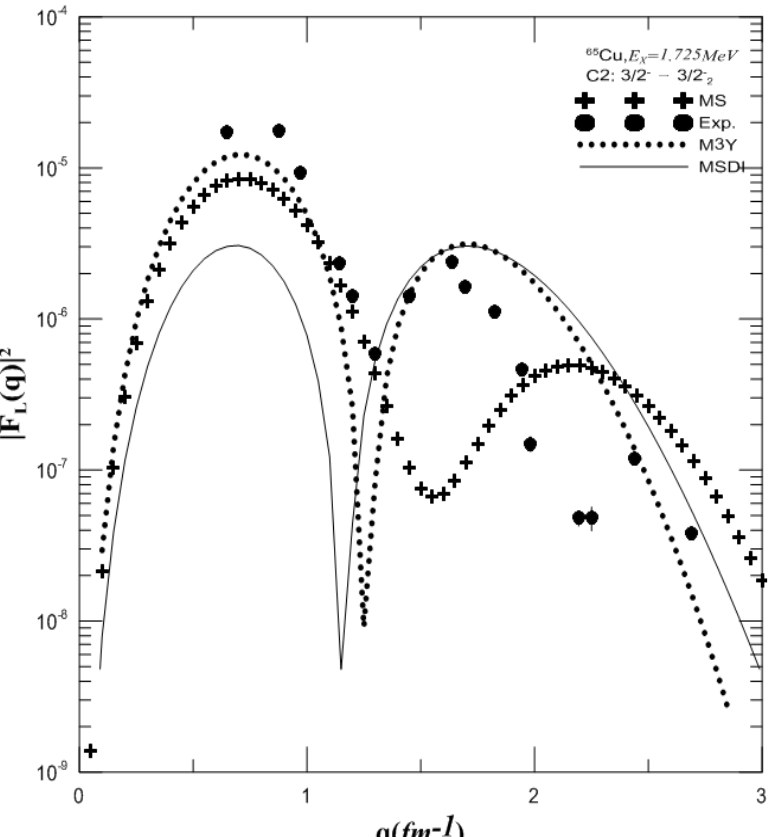
Fig.3: Inelastic longitudinal form factors for C2 transition 3/2 -  using MSDI and M3Y interactions with core-polarization effects, through particle-hole excitations up to 6ћω. The experimental data are taken from Ref.